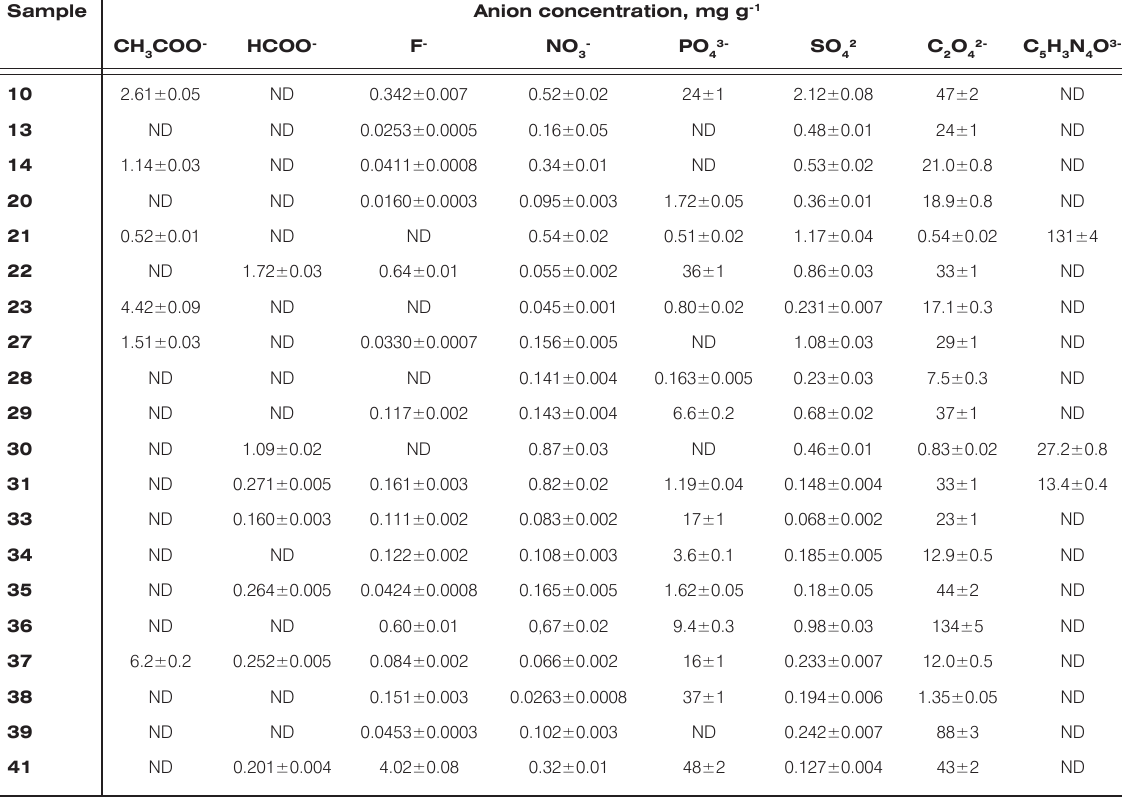
Table 1. Quantitative composition of urinary stones by IC method (ND: non detectable).